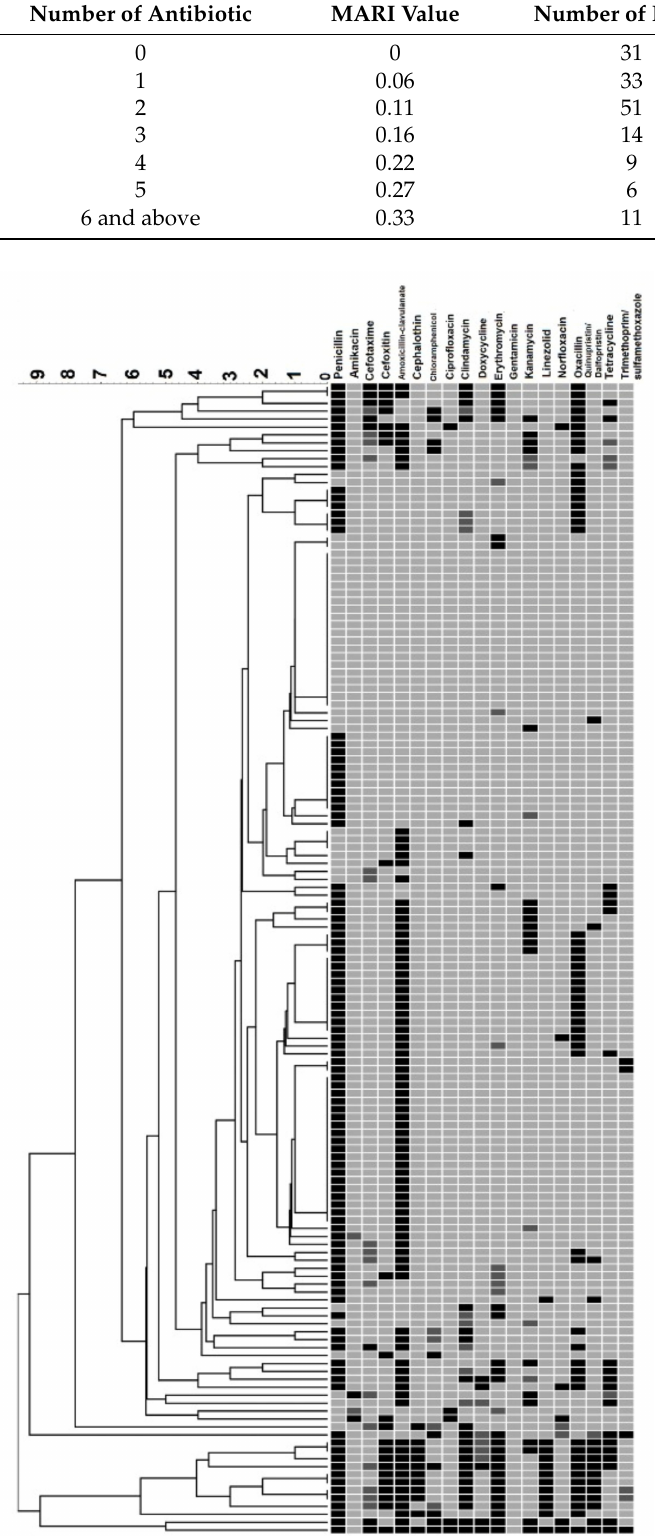
Figure 1. Dendrogram illustrating the relatedness of S. aureus based on phenotypic antibiotic resis- tance pattern. Black = resistant; dark grey = intermediate and light grey =